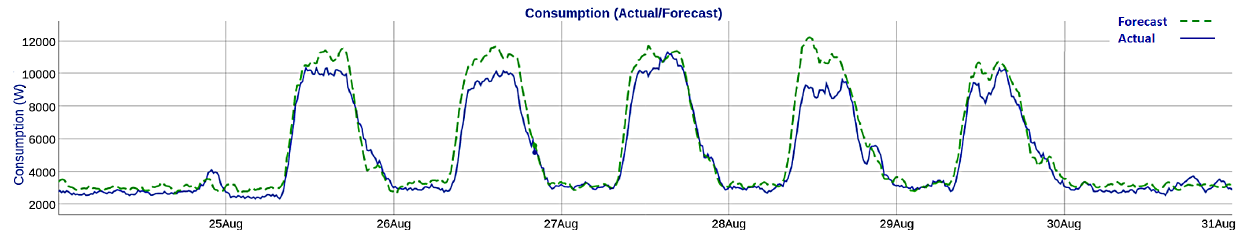
Figure 3. Comparison of actual and predicted